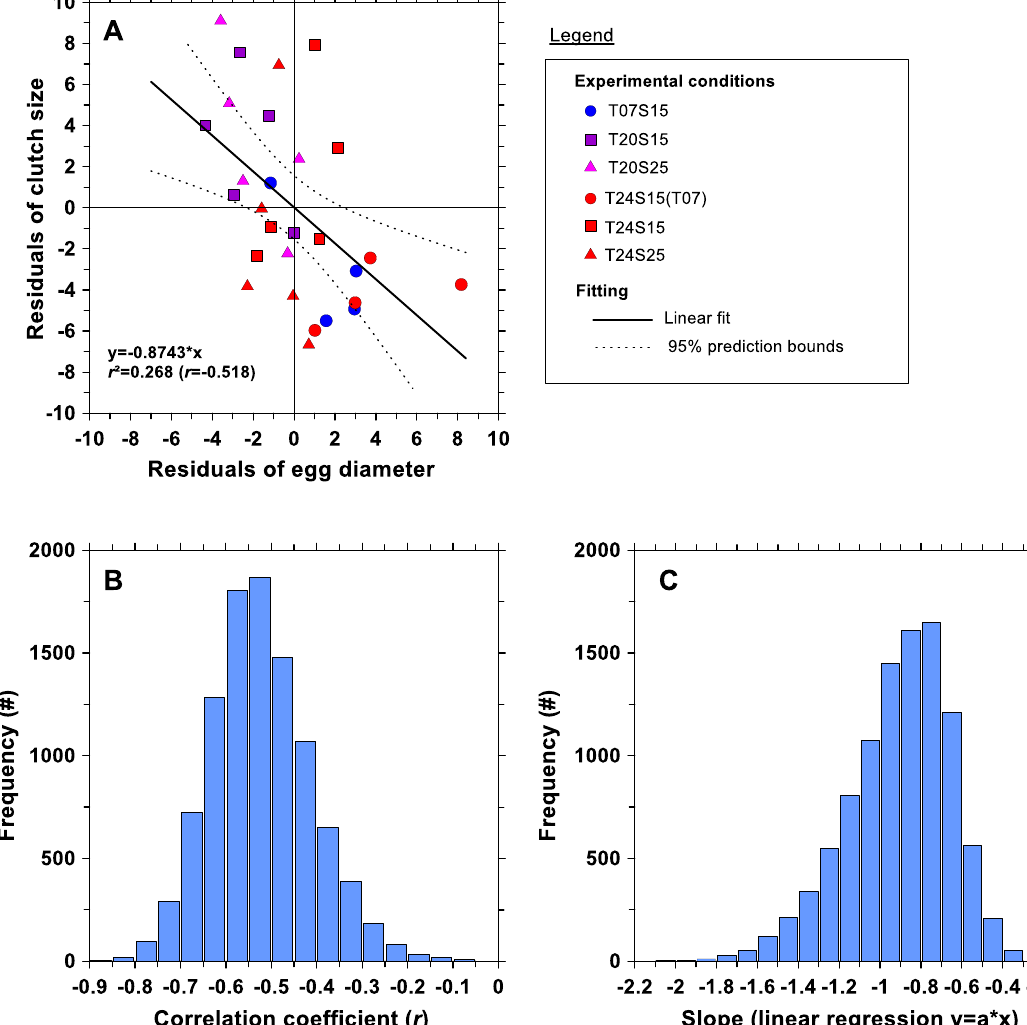
Figure 4. ( A ) Relationship between residuals of linear regressions of mean egg diameter and clutch size against female prosome length. The solid line is the regression line and the dashed lines are the 95% confidence interval. The grey lines intersect with the origin (0,0). The legend shows the labels of each population that are the same as in Fig. 3. ( B ) Histogram of the distribution of the 10,000 values of the coefficient of correlation ( r ) generated by the resampling bootstrap method. ( C ) Histogram of the distribution of the 10,000 values of the slope parameter of the linear regression y =